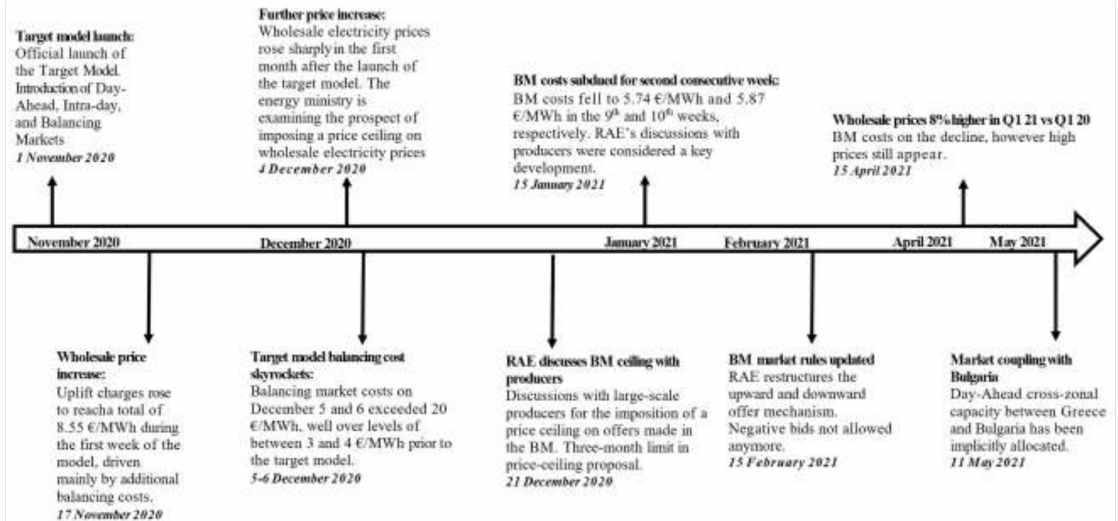
Figure 17. Timeline of important developments following the Target Model implementation in